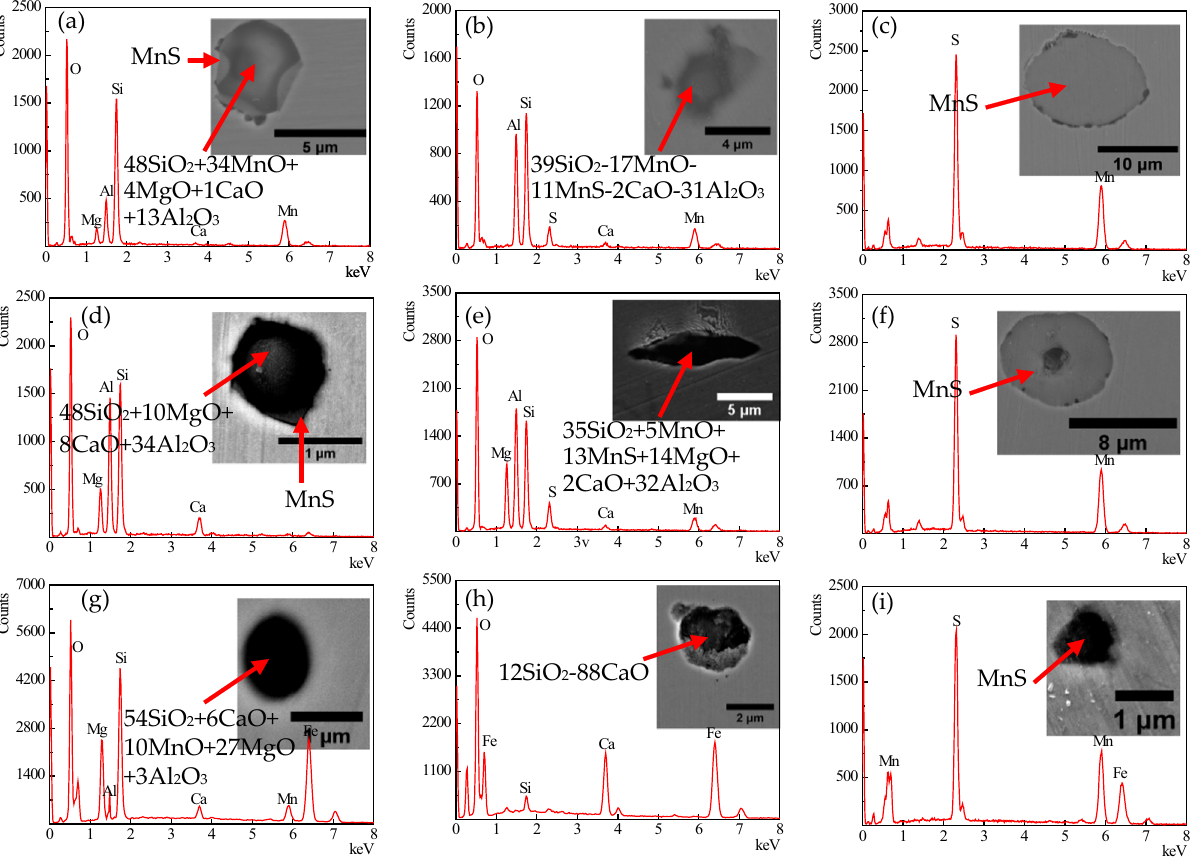
Figure 4: Typical inclusions in steel samples: ( a – c ) Cru - A , ( d – f ) Cru - MA , and ( g – i ) Cru - MC